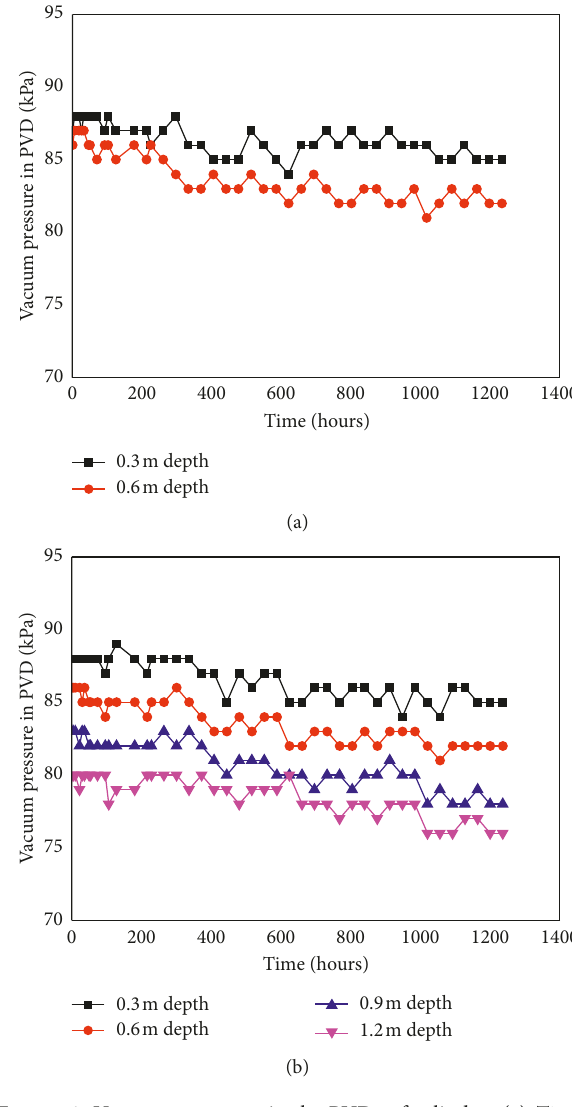
Figure 2: Vacuum pressures in the PVDs of cylinders (a) T 1 and (b) T 2 plotted as functions of time at various